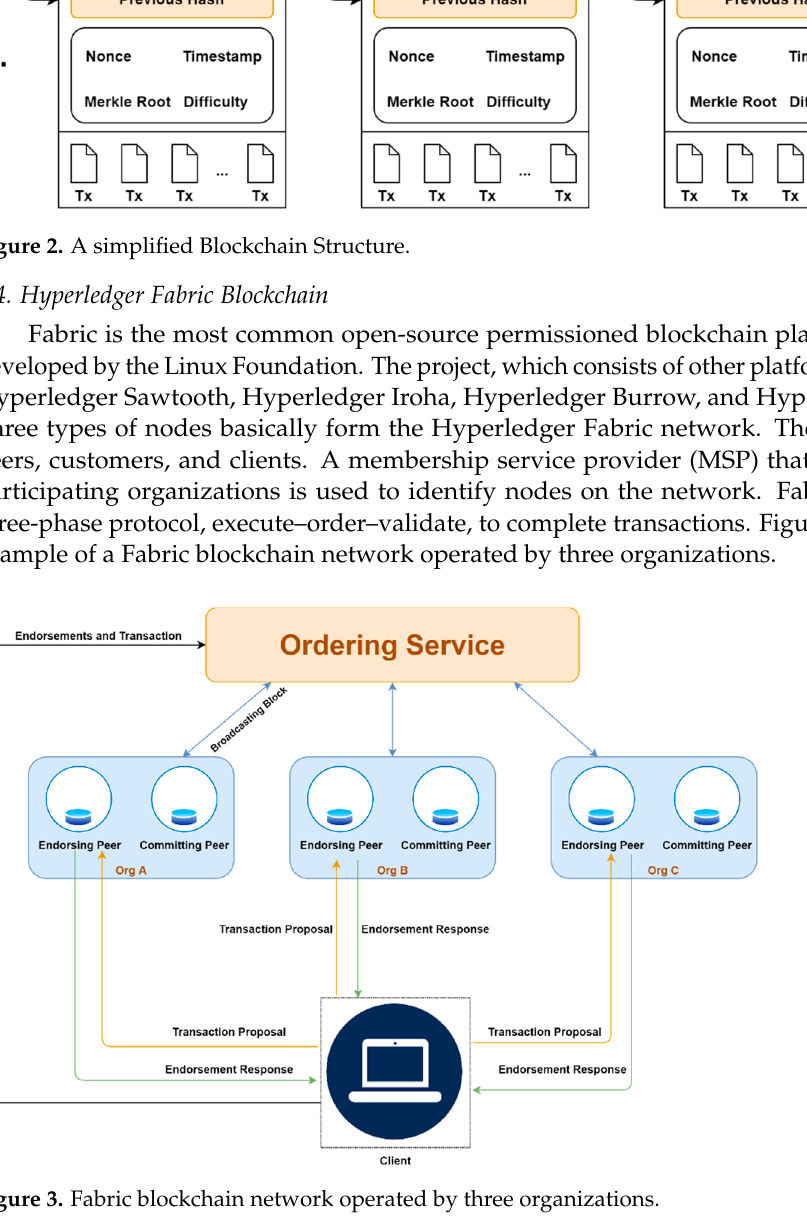
Figure 3. Fabric blockchain network operated by three organizations.